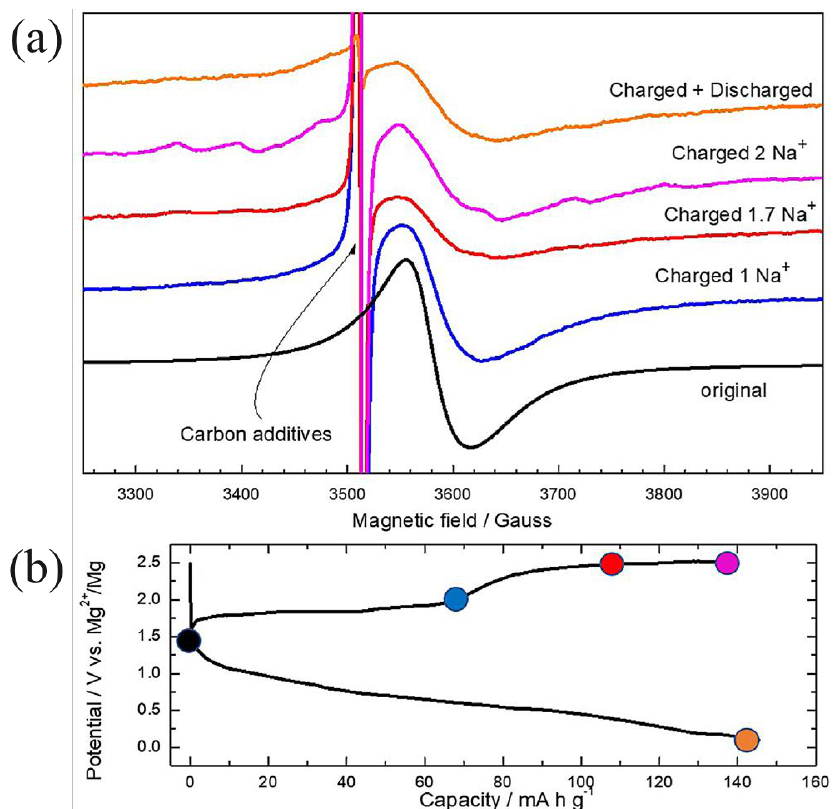
Figure 5. ( a ) The original EPR spectra of Na 5 V(PO 4 ) 2 F 2 and the corresponding EPR spectra under different sodium extraction amounts and complete discharge (measured at X band); ( b ) corresponding potential under different sodium extraction amount. Reproduced with permission from ref. [58]. Copyright 2021, copyright Elsevier.